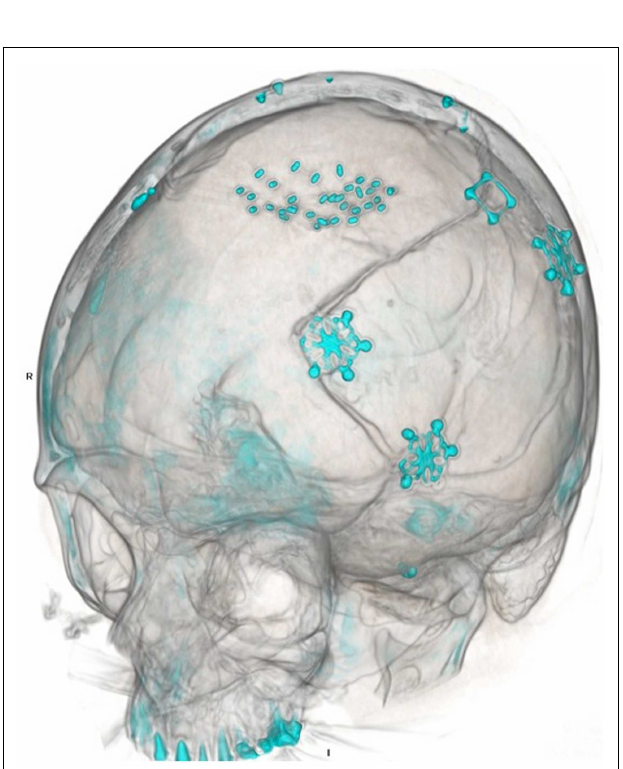
FIGURE 3 | Post-operative CT scan .Three-dimensional reconstruction demonstrates both prior craniotomies with microplate fixation, as well as radioactive brachytherapy seeds placed in the resection